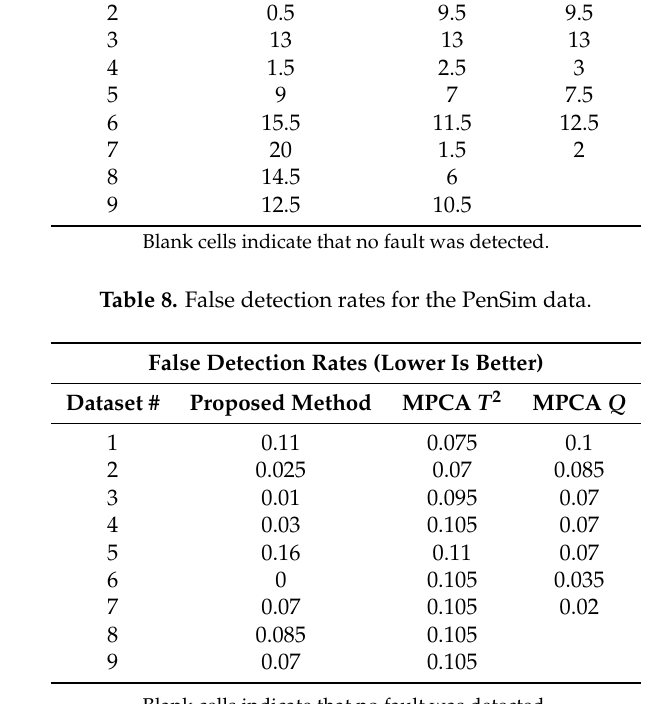
Blank cells indicate that no fault was